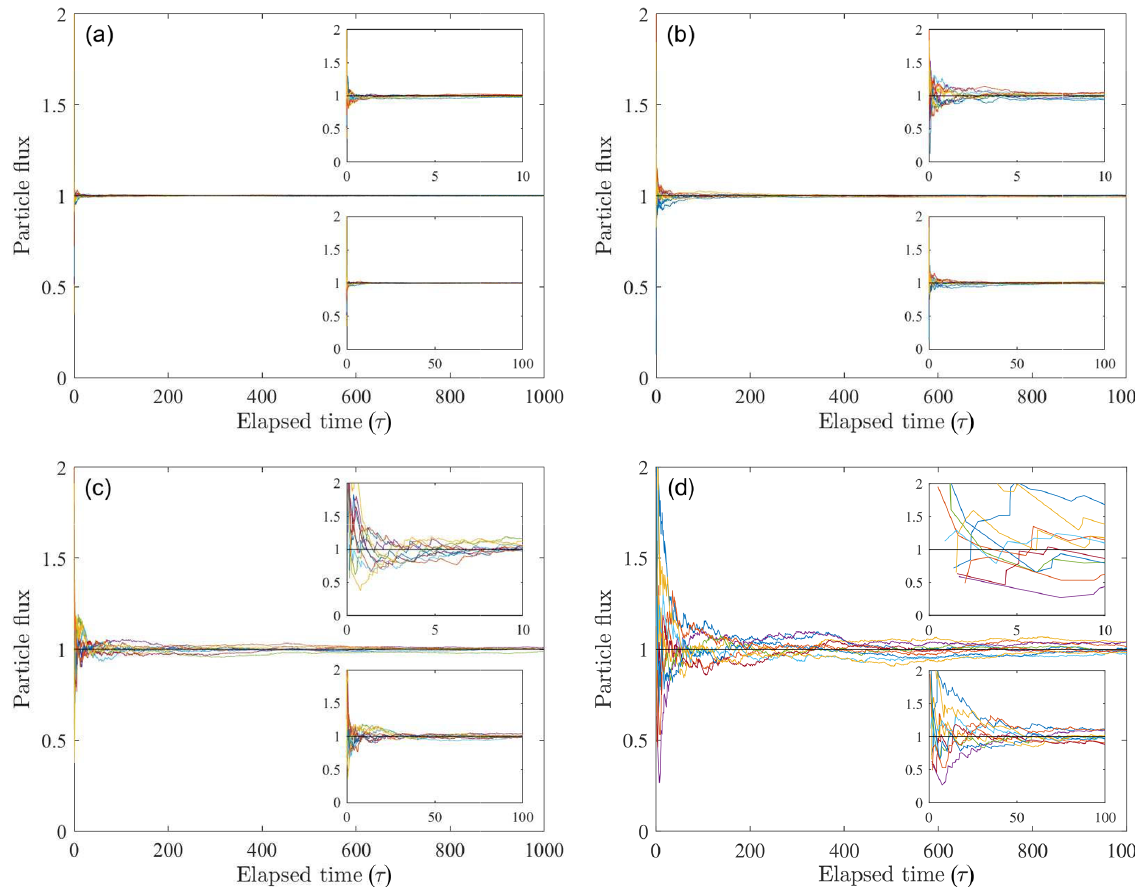
Figure 4. Plot of 10 realizations (colored lines) of normalized time-averaged particle number flux ˆ q n ( x ) versus elapsed time τ showing convergence to ensemble expected value (black line) with increasing τ . Plots coincide with conditions in Fig. 3. Note that initial values start at τ >